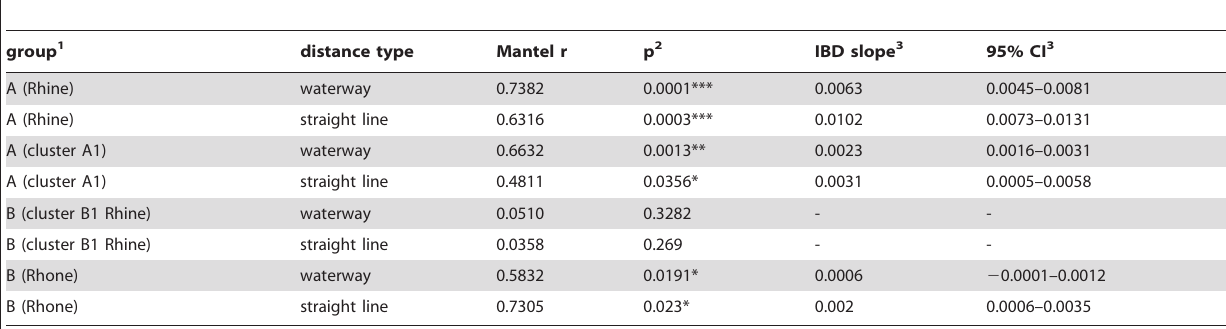
Table 1. Results of Mantel tests conducted to test for isolation by distance (geographical distance vs. F ST /(1-F ST )) in the program IBDWS for the cryptic Gammarus fossarum species type A and B in different drainages.